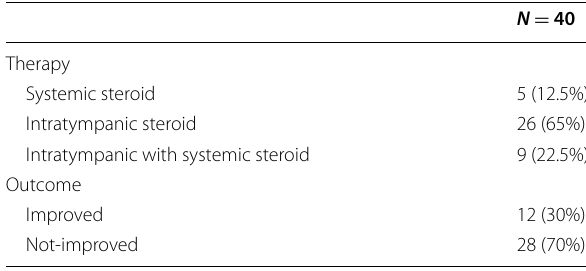
Table 2 Therapy and outcome among studied